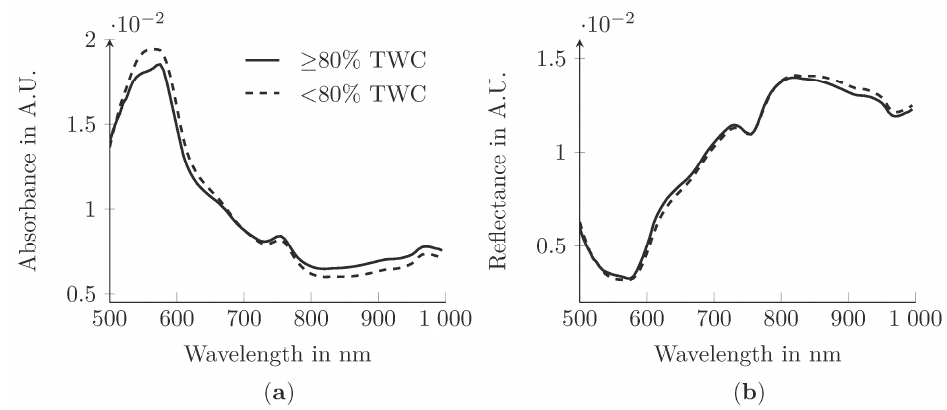
Figure 2. ( a ) Absorbance and ( b ) reflectance average spectra of kidneys with different TWC.